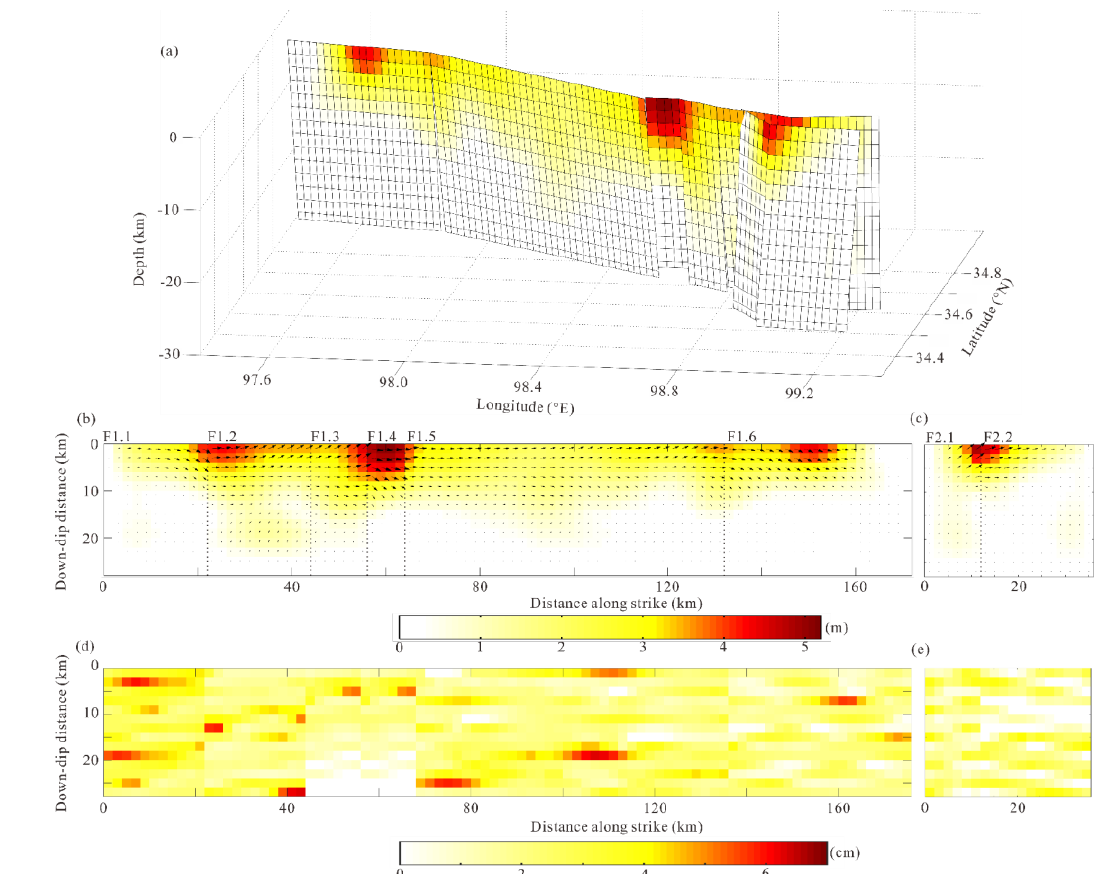
Figure 7. Fault slip model of the 2021 Maduo earthquake constrained by DInSAR observations. ( a ) F1 and F2 faulting model with three-dimensional view. Slip distribution on F1 ( b ) and F2 ( c ) and the corresponding error distributions on the F1 ( d ) and F2 ( e ) fault planes.